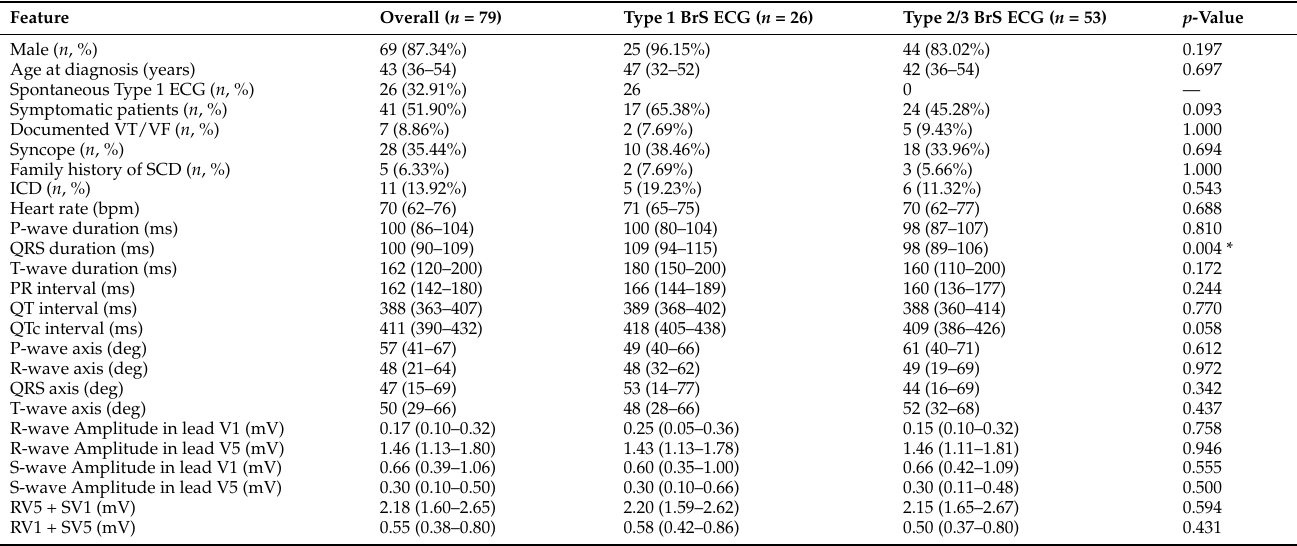
Table 1. Clinical and ECG characteristics of the included